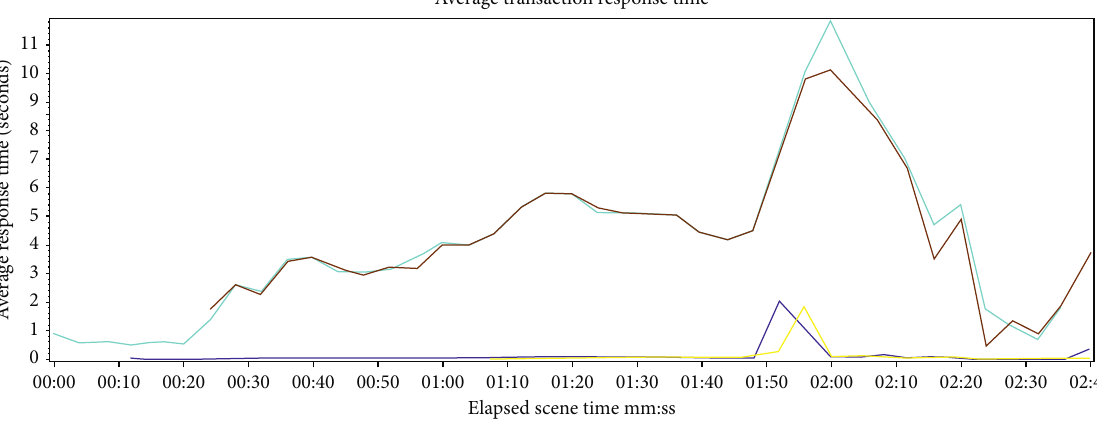
Figure 2: Average transaction response time for 50 concurrent